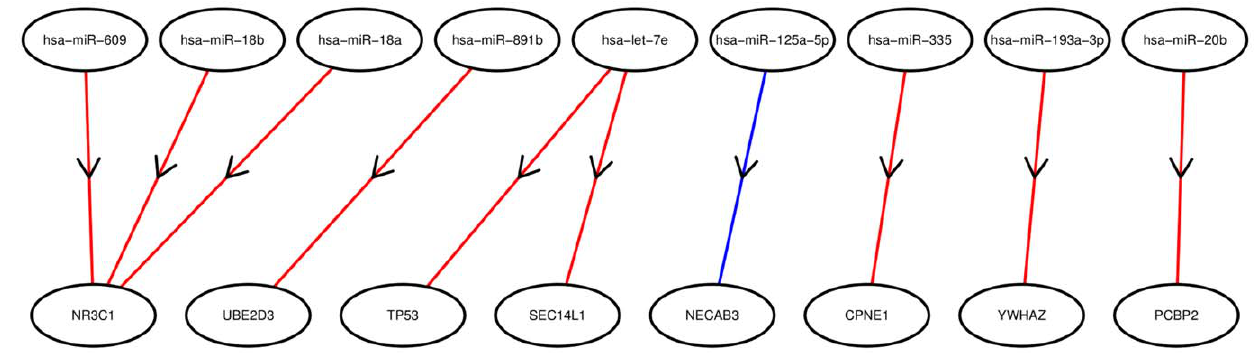
Figure 2. The top 10 interactions according to the G–O ordering. In the above diagram, we show the miRs (top row) and genes (bottom row) involved in the 10 most significant targeting interactions based on the G–O ordering from Figure 1. In each case, the inferred interaction is negative, meaning that the miR inhibits the expression of the corresponding gene. A red line from an miR to an mRNA indicates that the interaction was predicted by TargetScan and a blue line indicates that the interaction was predicted by miRanda .